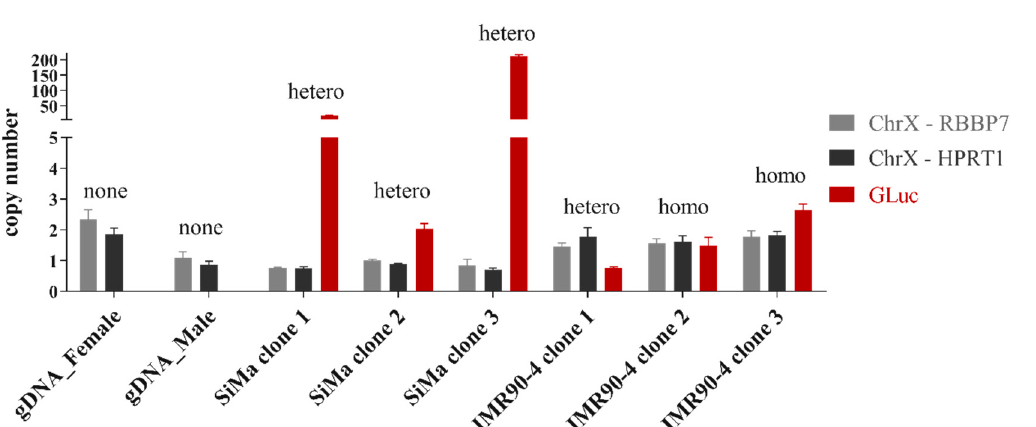
Figure 6. Copy numbers of RBBP7, HPRT1, and GLuc in selected clones determined by double- control quantitative copy-number PCR. Copy number calculated using the Δ Ct method, whereby GLuc/ChrX is normalized to the corresponding plasmid amplification and CHOP amplification. Values as displayed mean ± SD, n = 3. Results of GLuc insert confirmation from Figure 2B found above each copy-number column: none—no insert detected; hetero—heterozygous clone (insert detected in one allele); homo—homozygous clone (insert detected in both alleles).